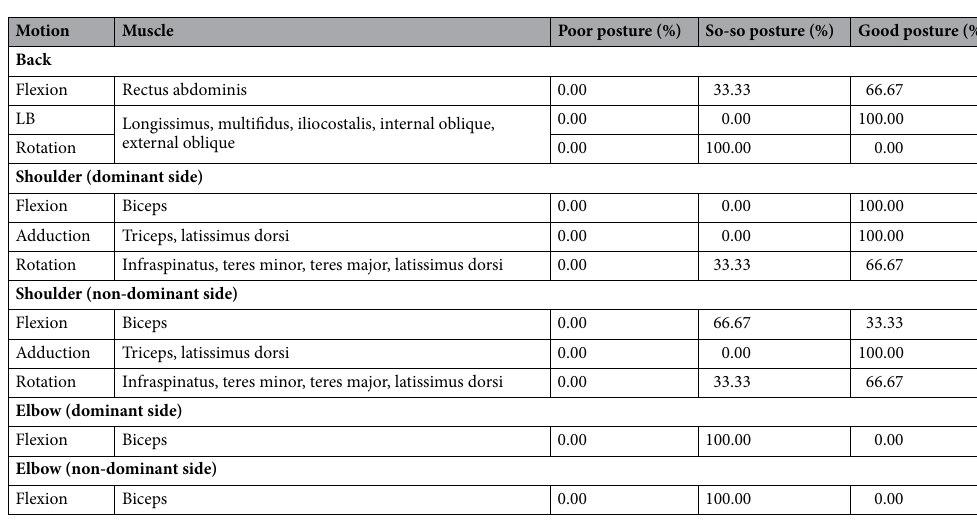
Table 8. Percentage of harvesters with poor, so-so and good postures for different types of back, shoulder and elbow joint motions ( n = 6)and their associated muscles 39